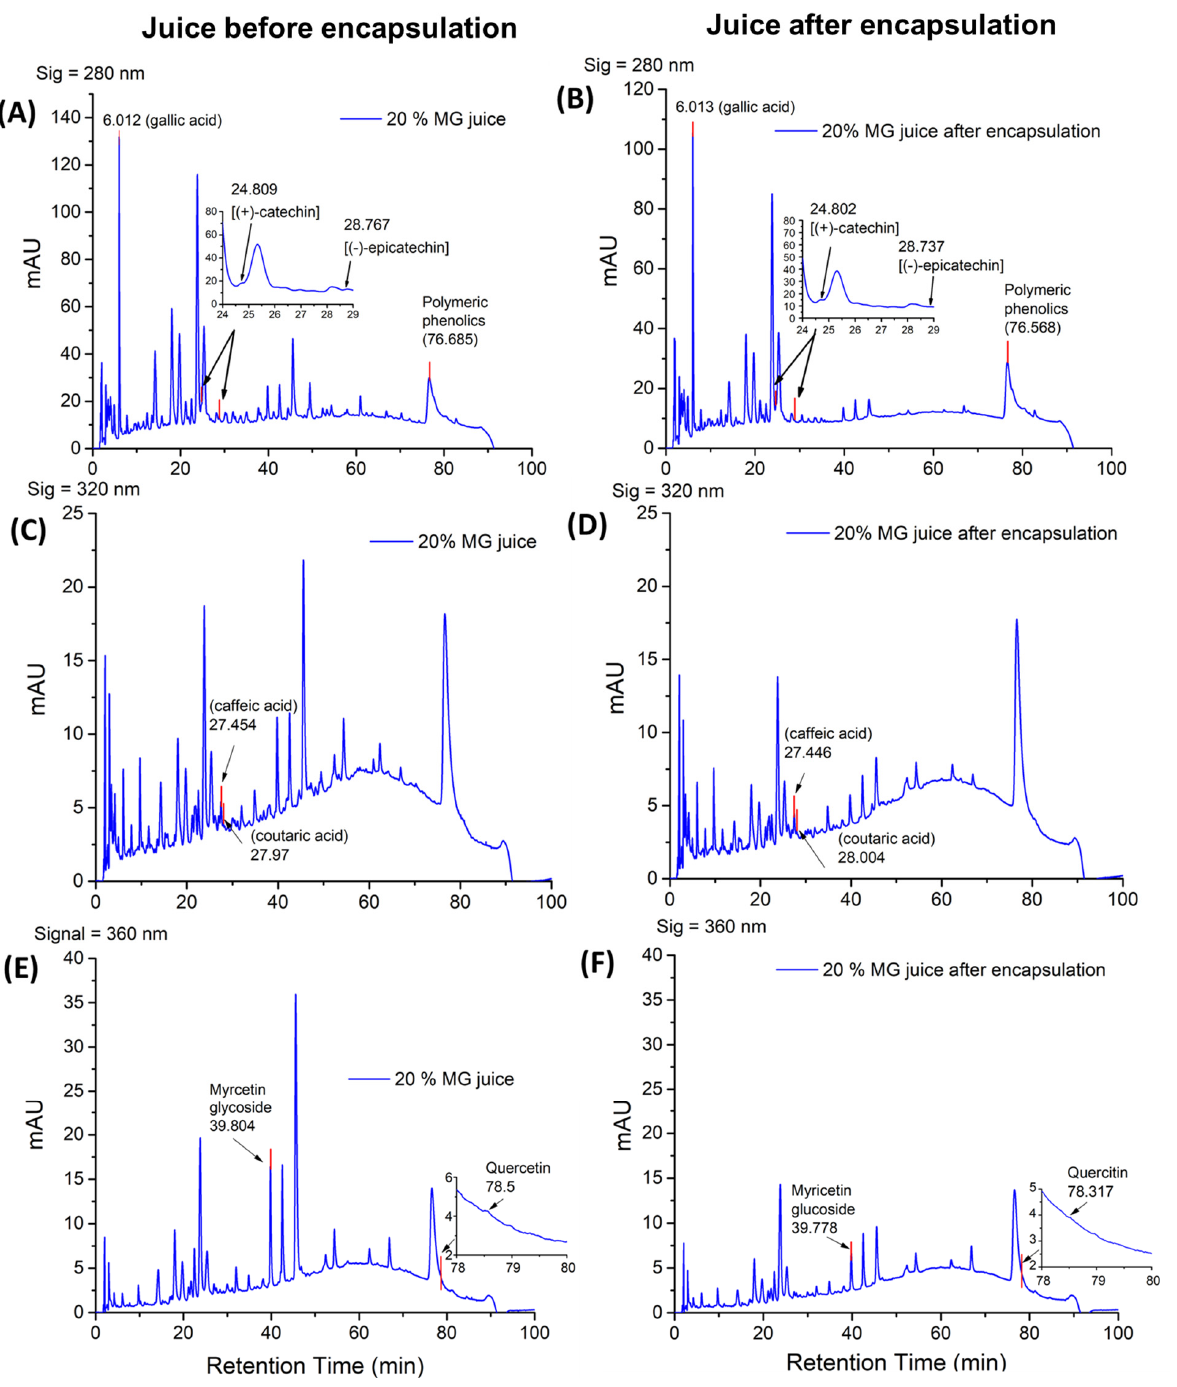
Figure 3. Chromatograms corresponding to absorbance peaks at 280 nm ( A , B ), 320 nm ( C , D ), and 360 nm ( E , F ) with assigned peaks for different phenolic compounds from 20% MG juice before (left) and after (right) encapsulation. Insets in Figure ( A , B ) illustrate a zoomed-in chromatogram region between a retention time of 24 to 29 min on the HPLC column to highlight the assigned peak for catechin and epicatechin in juice before and after encapsulation, respectively. Insets of ( E , F ) ill zoomed-in chromatogram section between the retention time of 78 to 80 min on the HPLC column to highlight the assigned peak for quercetin in juice before and after encapsulation.